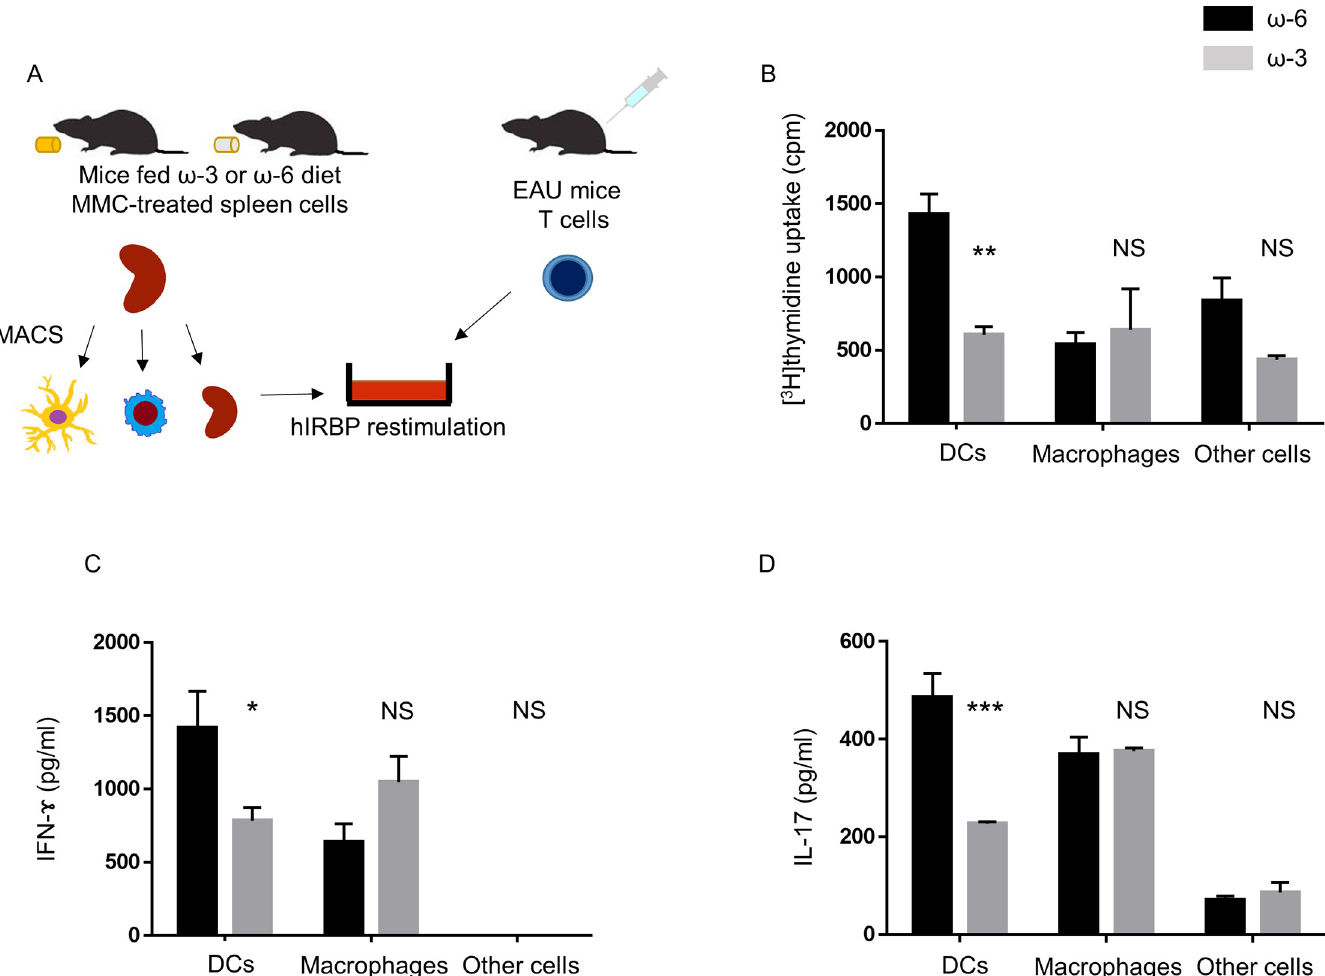
Fig 2. T cell proliferation as well as IFN- γ and IL-17 production in cocultures of CD4 + T cells from EAU mice and APC fractions from mice fed ω -3 or ω -6 LCPUFAs. (A) Experimental scheme. Mitomycin C–treated spleen cells isolated and separately pooled from mice fed a diet supplemented with ω -3 ( n = 5) or ω -6 ( n = 5) LCPUFAs were fractionated by MACS into DCs, macrophages, and other spleen cells. Each cell fraction (3 × 10 5 cells) was incubated for 48 h in the presence of hIRBP(1–20) (10 μ g/ml) and with CD4 + T cells (3 × 10 5 ) isolated and pooled from EAU mice ( n = 5). (B) The proliferation of the T cells was then assessed by measurement of [ 3 H]thymidine incorporation. Data are means + SEM from three independent experiments. (C, D) The concentrations of IFN- γ (C) and IL-17 (D) in the coculture supernatants were measured with ELISAs. Data are means + SEM of triplicates from one experiment and are representative of three independent experiments. � P < 0.05, �� P < 0.01, ��� P < 0.001; NS, not significant versus corresponding value for the ω -6 LCPUFA diet (Sidak’s multiple comparison test).